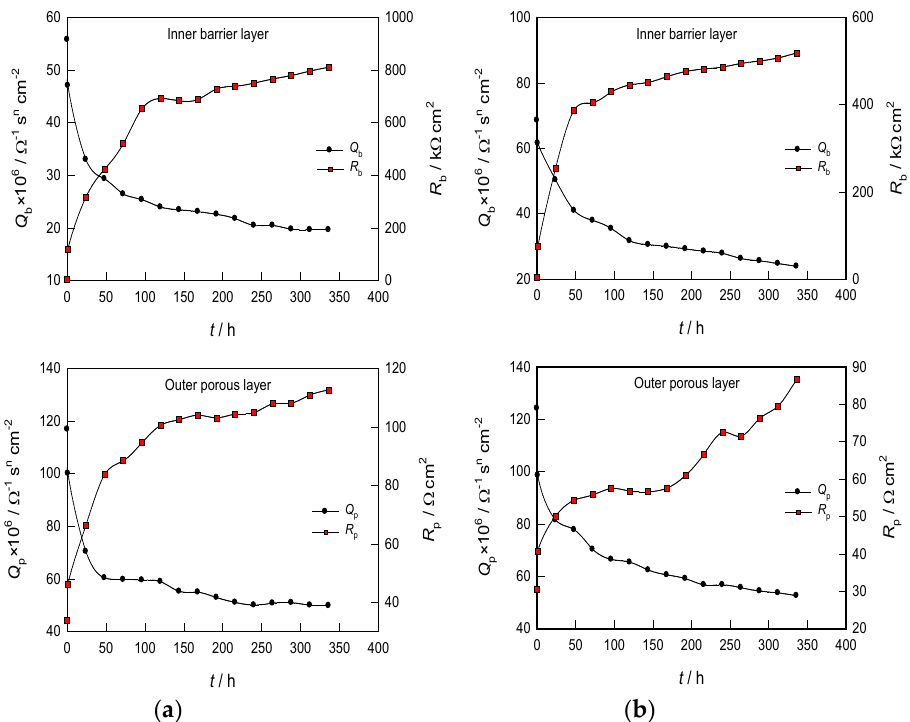
Figure 8. Dependence of the inner barrier layer ( Q b and R b ) and the outer porous layer ( Q p and R p ) parameters on the stabilization time for ( a ) CP Ti and ( b ) Ti-6Al-4V alloy in PBS. According to the plate capacitor model, the capacity is inversely proportional to the thickness, d ( C = ε ε o / d ; where ε o is the dielectric constant of vacuum (8.85.10 -12 F m − 1 ), and ε is the dielectric constant of the TiO 2 film ( ≈ 100) [40 ] . Therefore, the decrease in the size of Q (from ≈ 55 to ≈ 19 × 10 − 6 Ω − 1 s n cm − 2 ) with increasing time corresponds to an adequate increase in the thickness of the barrier part of the oxide layer.